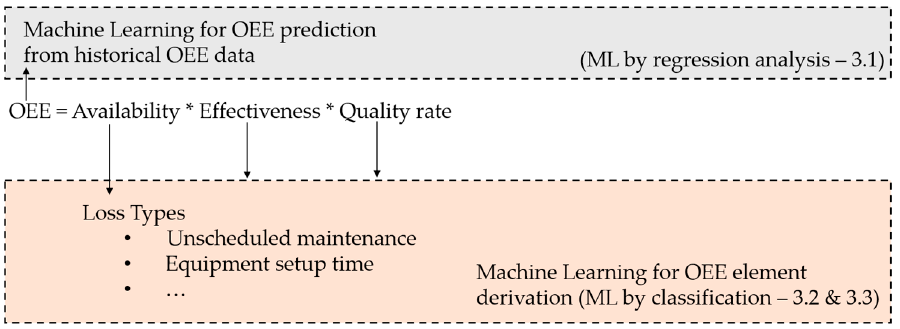
Figure 1. OEE in the context of Machine Learning.